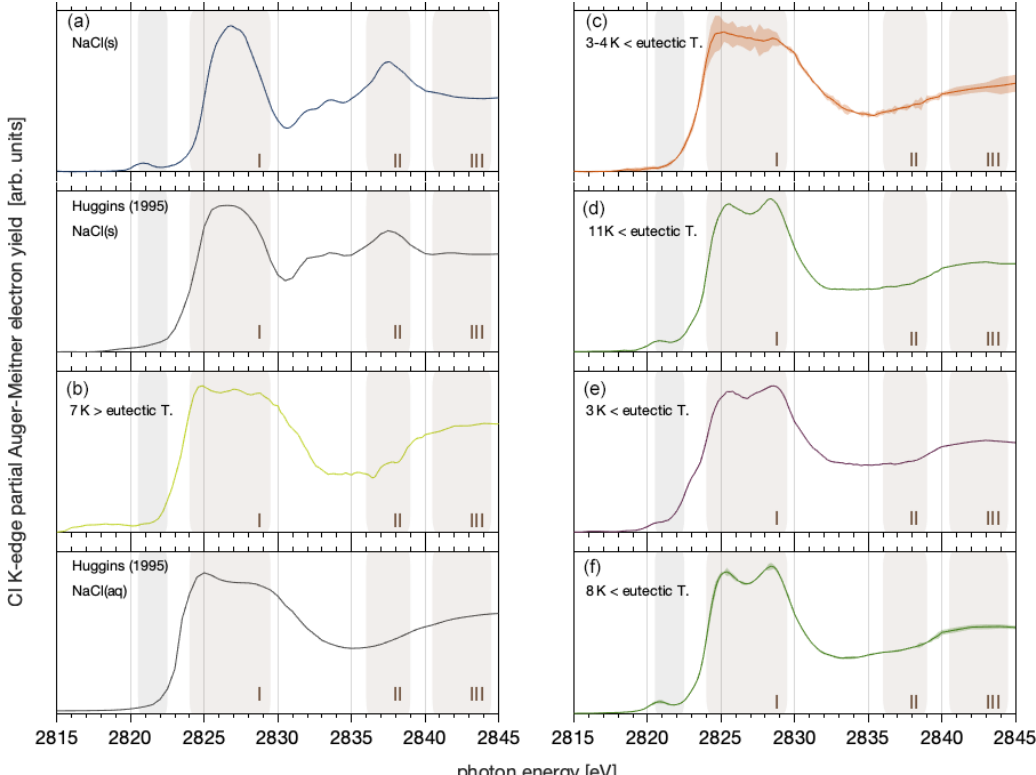
Figure 3. Partial electron yield chlorine K-edge NEXAFS spectra of the sodium chloride–water binary system: (a) Sample A – solid NaCl at 248K and 44% relative humidity (0.34mbar water vapour pressure). (b) Sample B – Aqueous NaCl solution in equilibrium with ice at 88% RH (1.82mbar) and 259K. (c) Sample C – an averaged spectrum at the thermodynamic ice stability line at 248K to 249K and 78% (0.60mbar) to 80% (0.71mbar) RH. (d) Sample D – an individual spectrum upon further cooling to 241K and 74% RH (0.29mbar). (e) Sample E – an individual spectrum upon heating back to 249K in the ice stability domain at 79% RH (0.69 mbar). (f) Sample F – the averaged spectrum at 244K and a RH of 59% (0.32mbar) and 73% (0.40mbar), lower than the ice stability domain. See Fig. 4 for